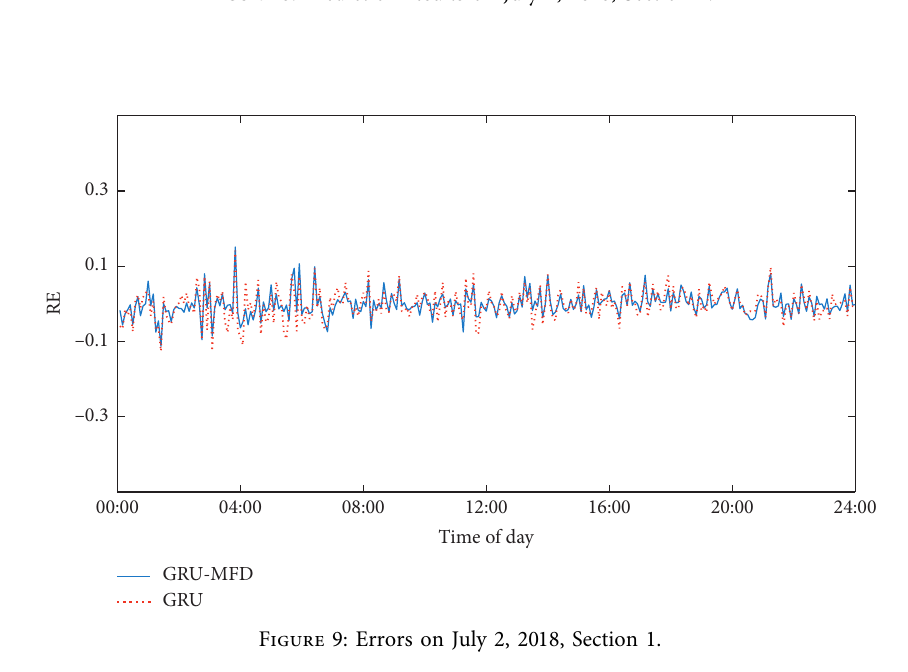
Figure 9: Errors on July 2, 2018, Section 1.